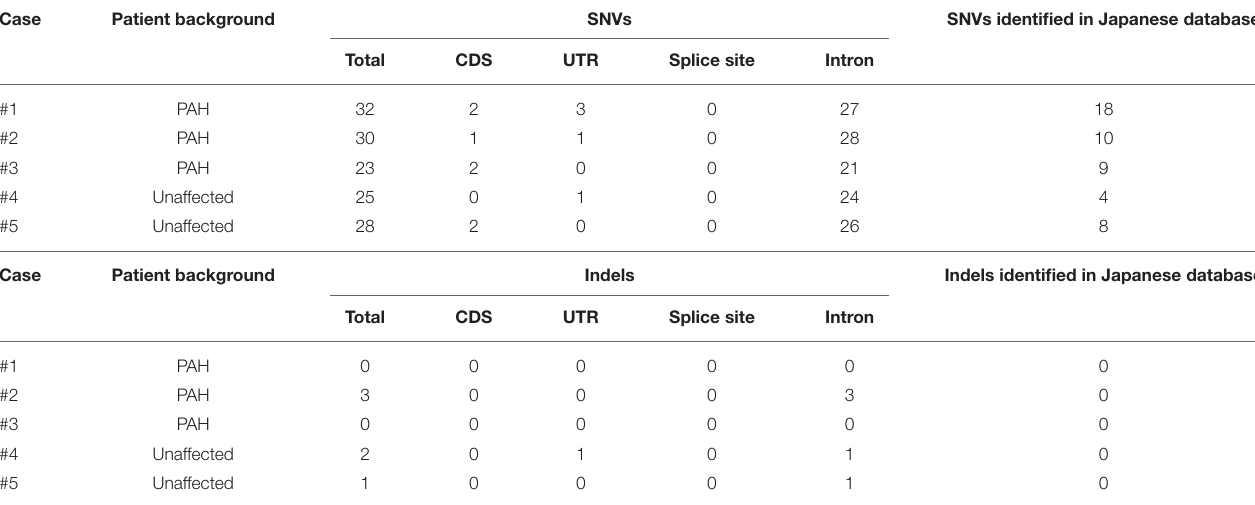
TABLE 2 | Number and type of all BMPR2 variants detected using MinION